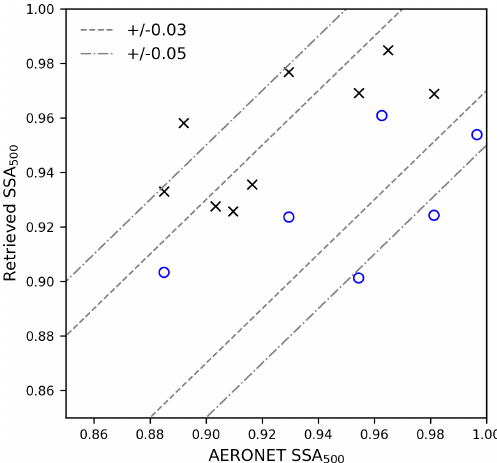
Figure 15. SVR-retrieved SSA (black crosses) and OMAERUV- retrieved SSA (blue circles) against AERONET SSA at 500nm for all five cases in this